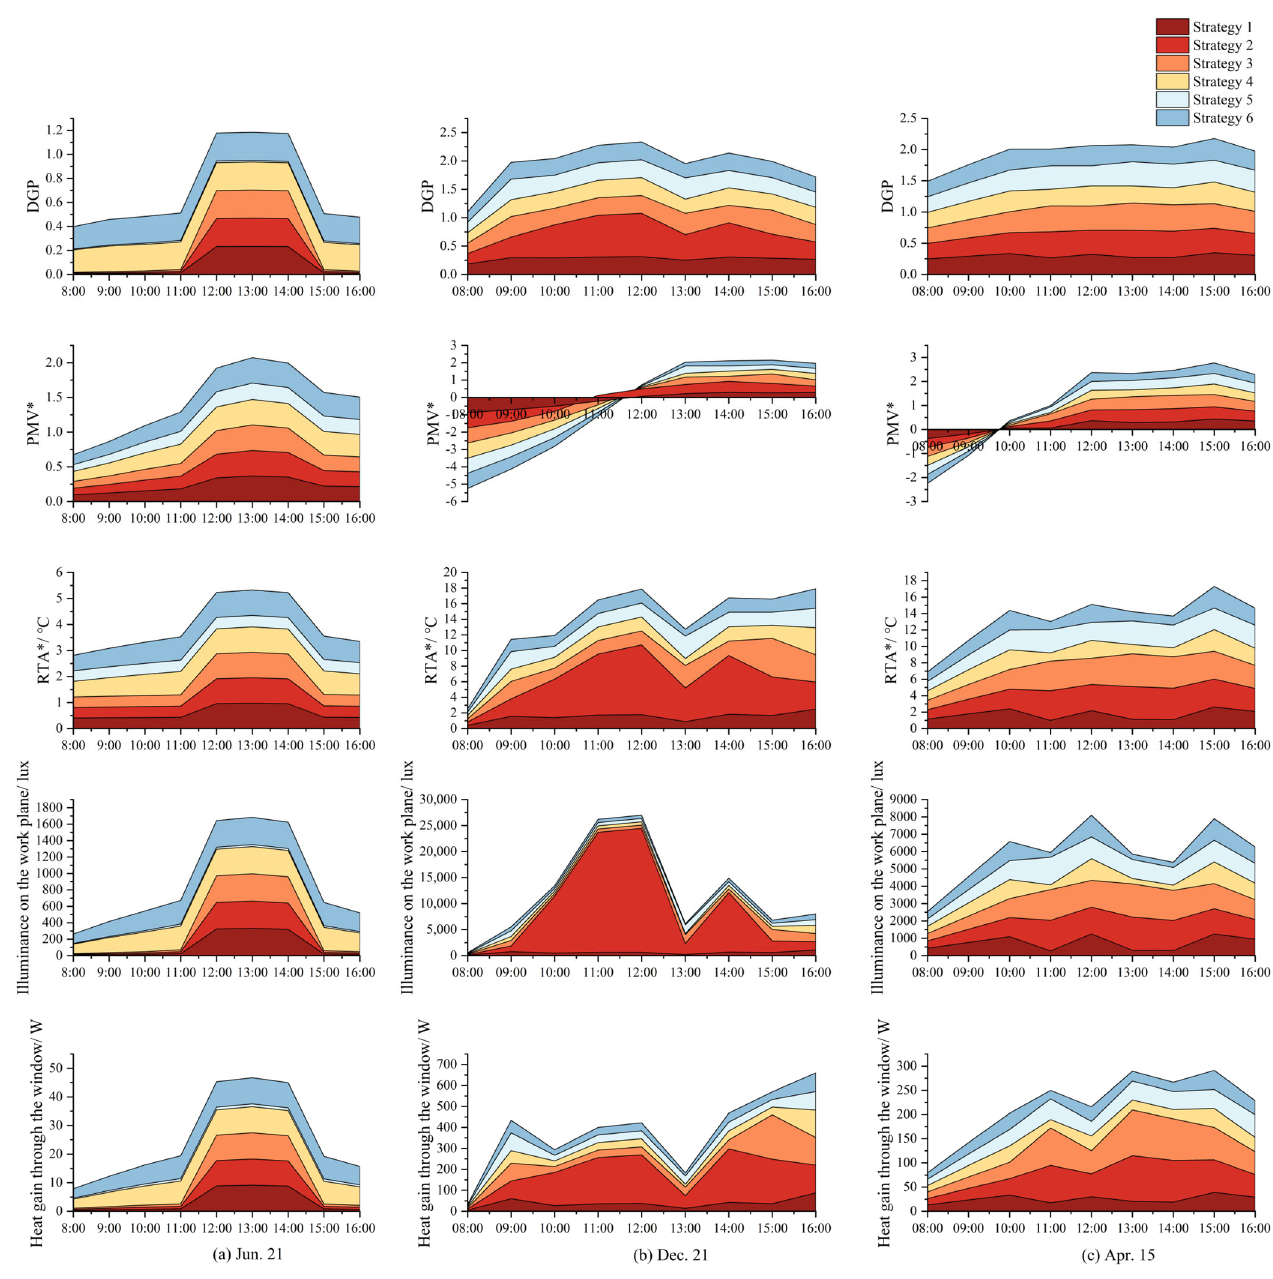
Figure 9. Index accumulation chart of three typical days in case 1.